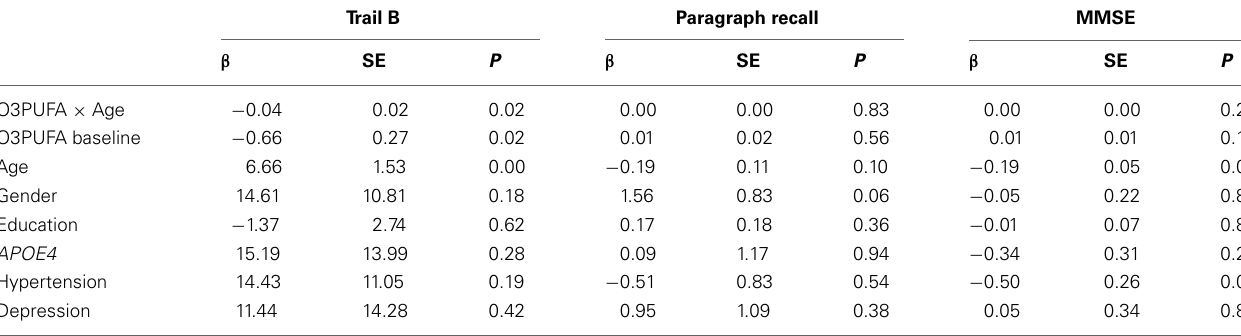
Table 2 | Plasma O3PUFA and cognitive decline in older adults over 4-years ( n = 86) a . Trail B